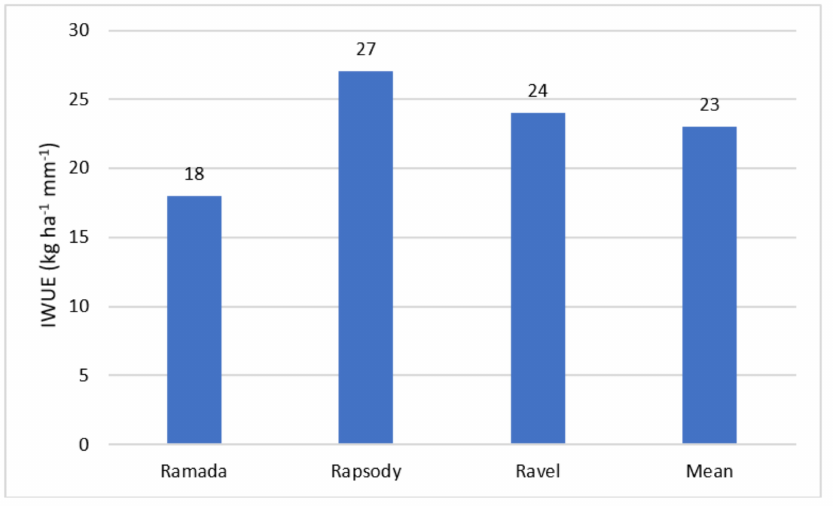
Figure 5. Irrigation water use efficiency (kg ha − 1 mm − 1 ) as dependent on cultivar, mean for harvest periods